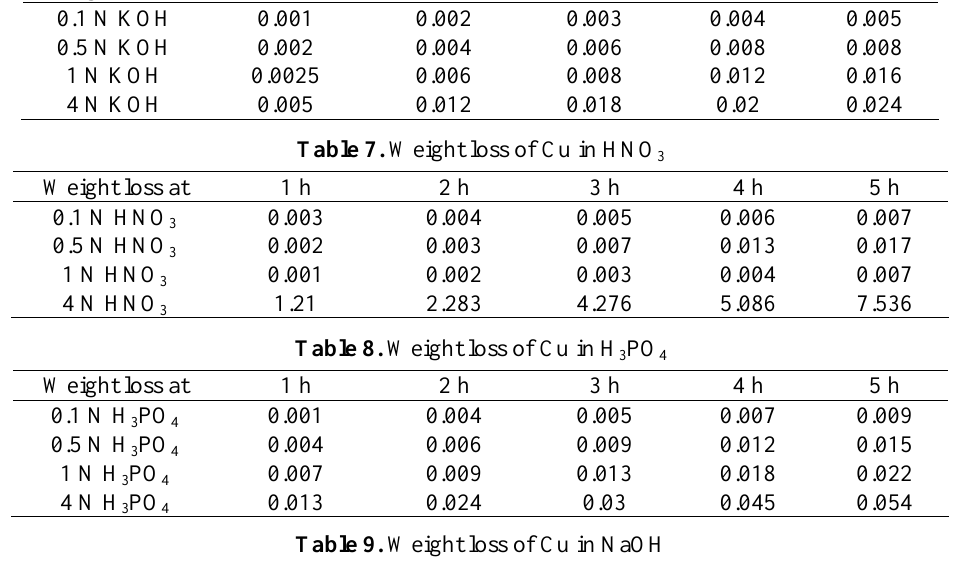
Table 9. Weight loss of Cu in NaOH